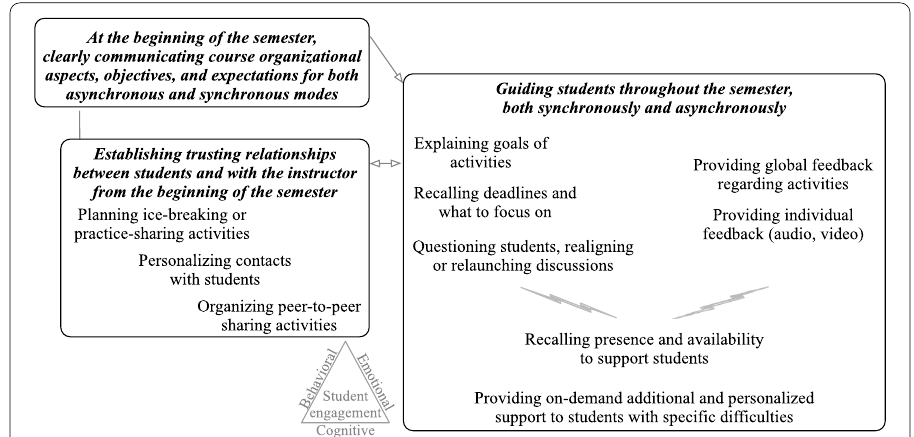
Fig. 3 Teachers’ strategies relative to course relationships and their